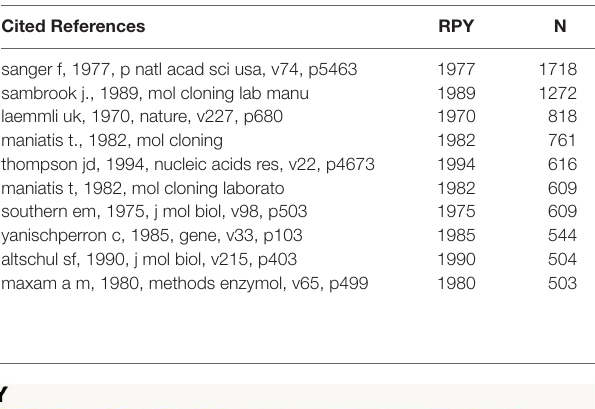
TaBle 3 | Ten most-cited publications in Gene (without disambiguation using crexplorer); February 14,